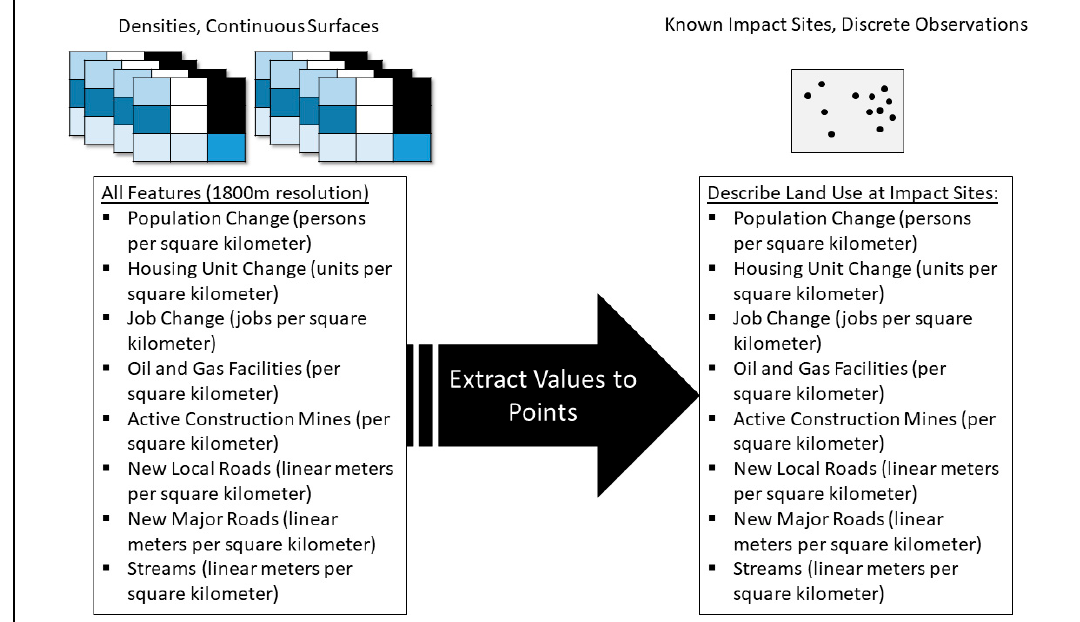
Figure A2. Characterizing land use and land use change at known impact sites.